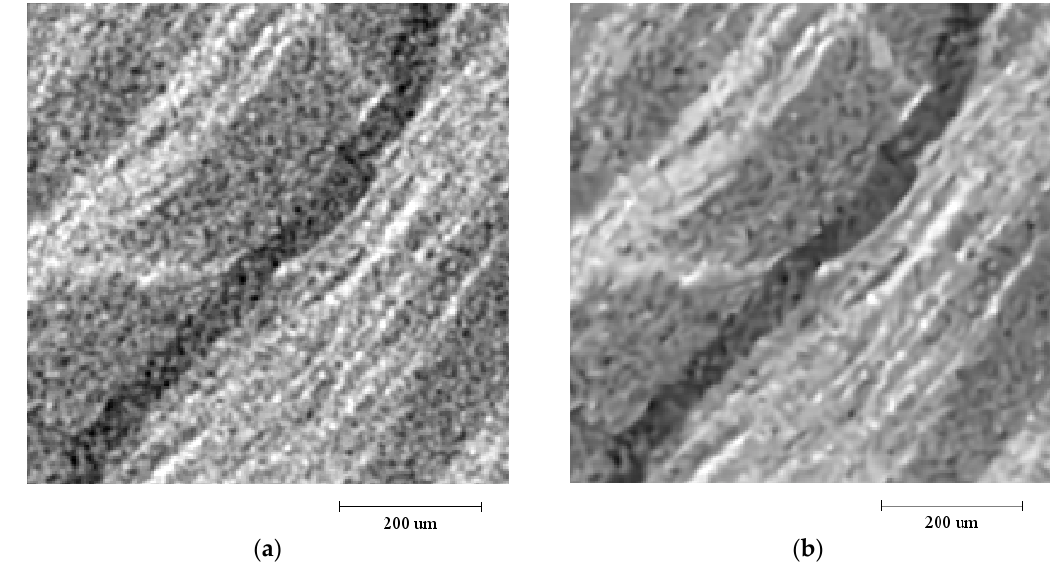
Figure 3. A slice of a coal sample: ( a ) original grayscale image, ( b ) after image smoothing and de-noising.